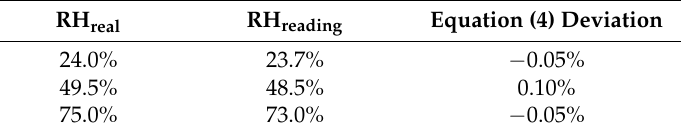
Table 1. Producer calibration data for the Extec RH390 precision psychrometer (in a Binder KBF-115 climate chamber, serial No. 09-06299, Binder GmbH, Ulm, Germany, traceable to Scalibra AS, Skjetten, Norway, proof No.